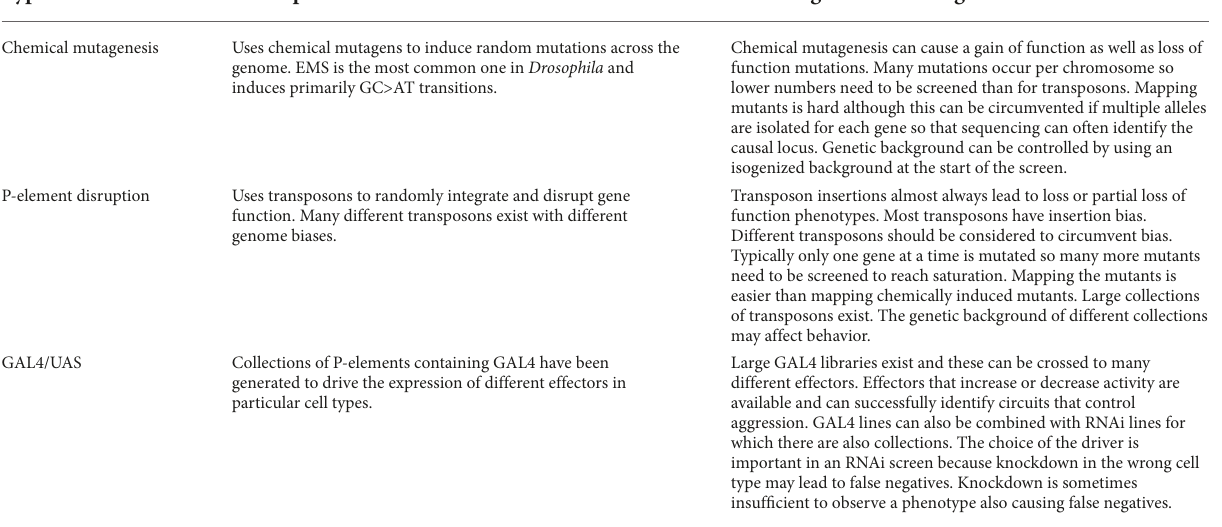
TABLE 1 Types of screens for analyzing aggression. Type of